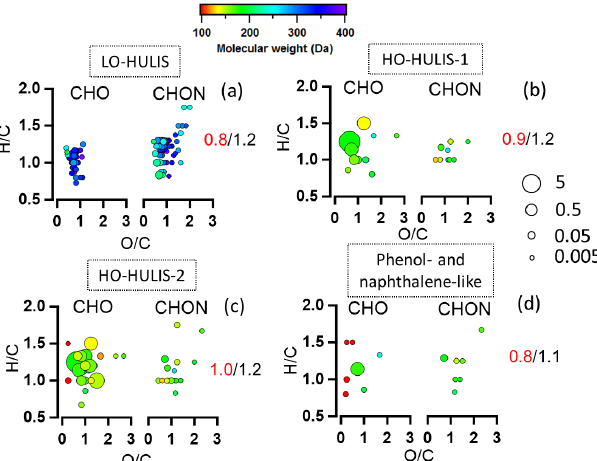
Figure 7. The van Krevelen plots of molecule families associ- ated with each PARAFAC component (C1–C4). Data points are coloured by molecular weight. The molecules are split by C x H y O z and C x H y O z N 1 . The values in each plot are O / C ratios (red) and H / C ratios (black). The size of the circles is the relative contribution to the total brown carbon signals of each compound. (a) Molecules associated with the LO-HULIS component; (b) molecules associ- ated with the HO-HULIS-1 component; (c) molecules associated with the HO-HULIS-2 component; (d) molecules associated with the phenol- and naphthalene-like